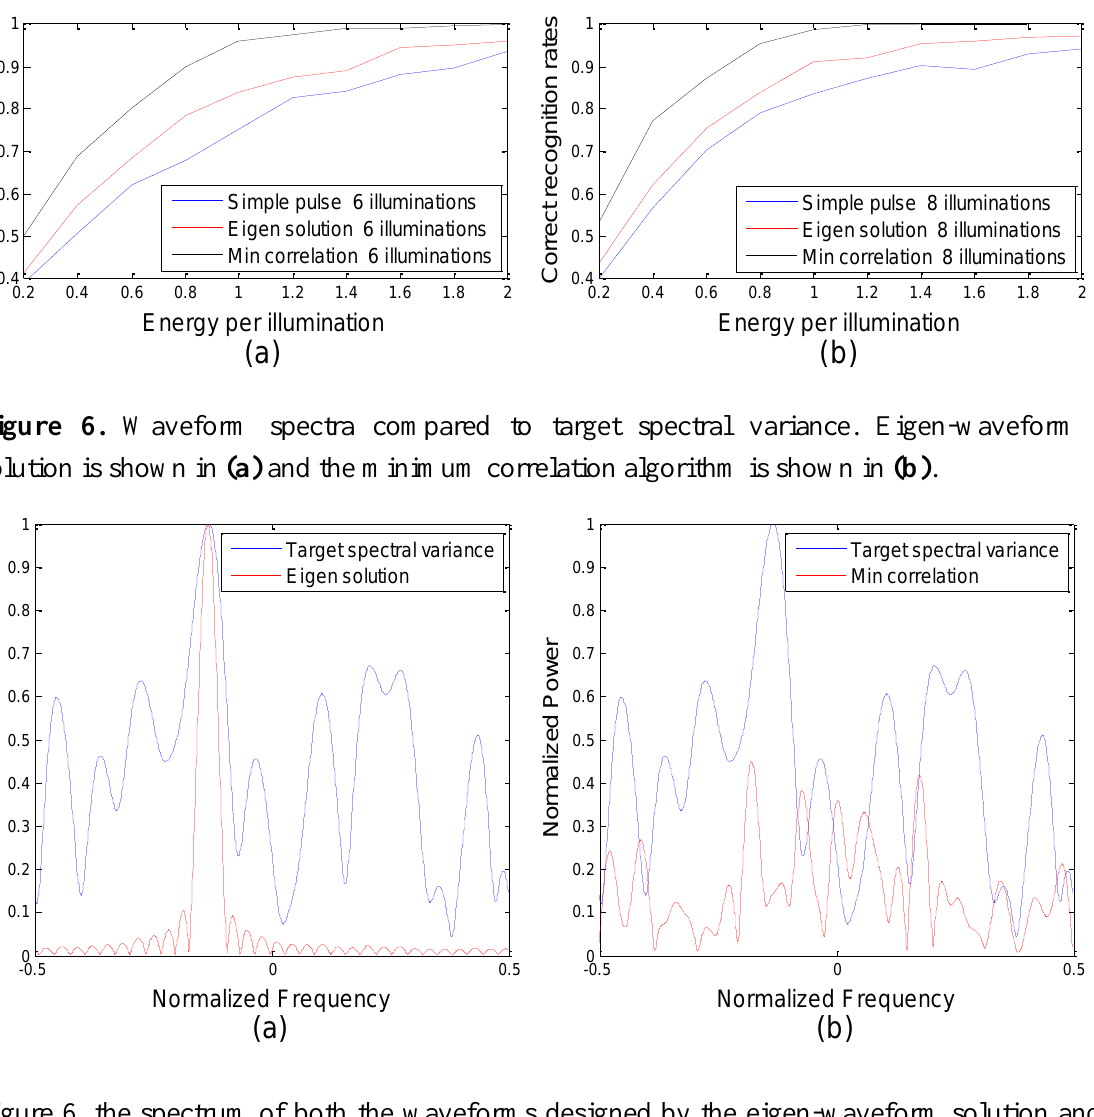
Figure 5. Correct recognition rates after six (a) or eight (b) illuminations vs. energy per illumination. The hypothesis with maximum probability is selected to be true after six (a) or eight (b) illuminations.